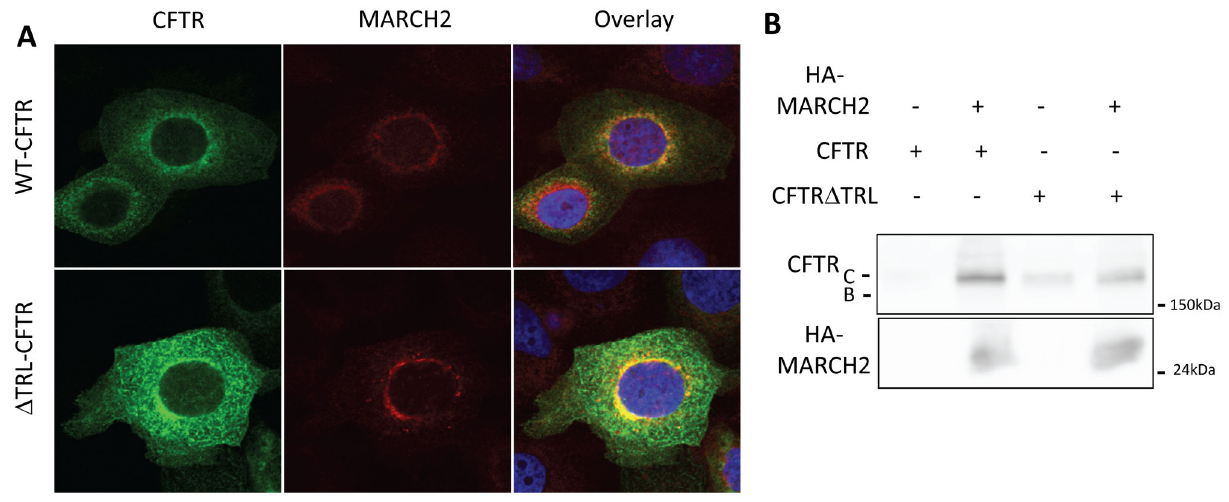
Figure 7. Localization and interaction of MARCH2 with wild-type and Δ TRL CFTR. ( A ) CBFE cells grown on coverslips were co-transfected with 3µg GFP-CFTR or 3µg GFP-ΔTRL-CFTR and 0.5 µg HA-MARCH2. After 24h, the cells were fixed and subjected to indirect fluorescent immunocytochemical staining with an anti-HA mouse monoclonal antibody and anti-GFP rabbit polyclonal antibody. HA-MARCH2 appears red and GFP-CFTR green. ( B ) HEK293 cells were co-transfected with 3 µg GFP-CFTR or 3µg GFP-ΔTRL-CFTR and 1 µg HA-MARCH2, as indicated. After 48 h, cell lysates were harvested and immunoprecipitated with an anti-HA affinity matrix. Cell lysates and immunoprecipitated materials were subjected to immunoblot analysis with the indicated antibodies. Data shown are representative of at least three independent experiments.